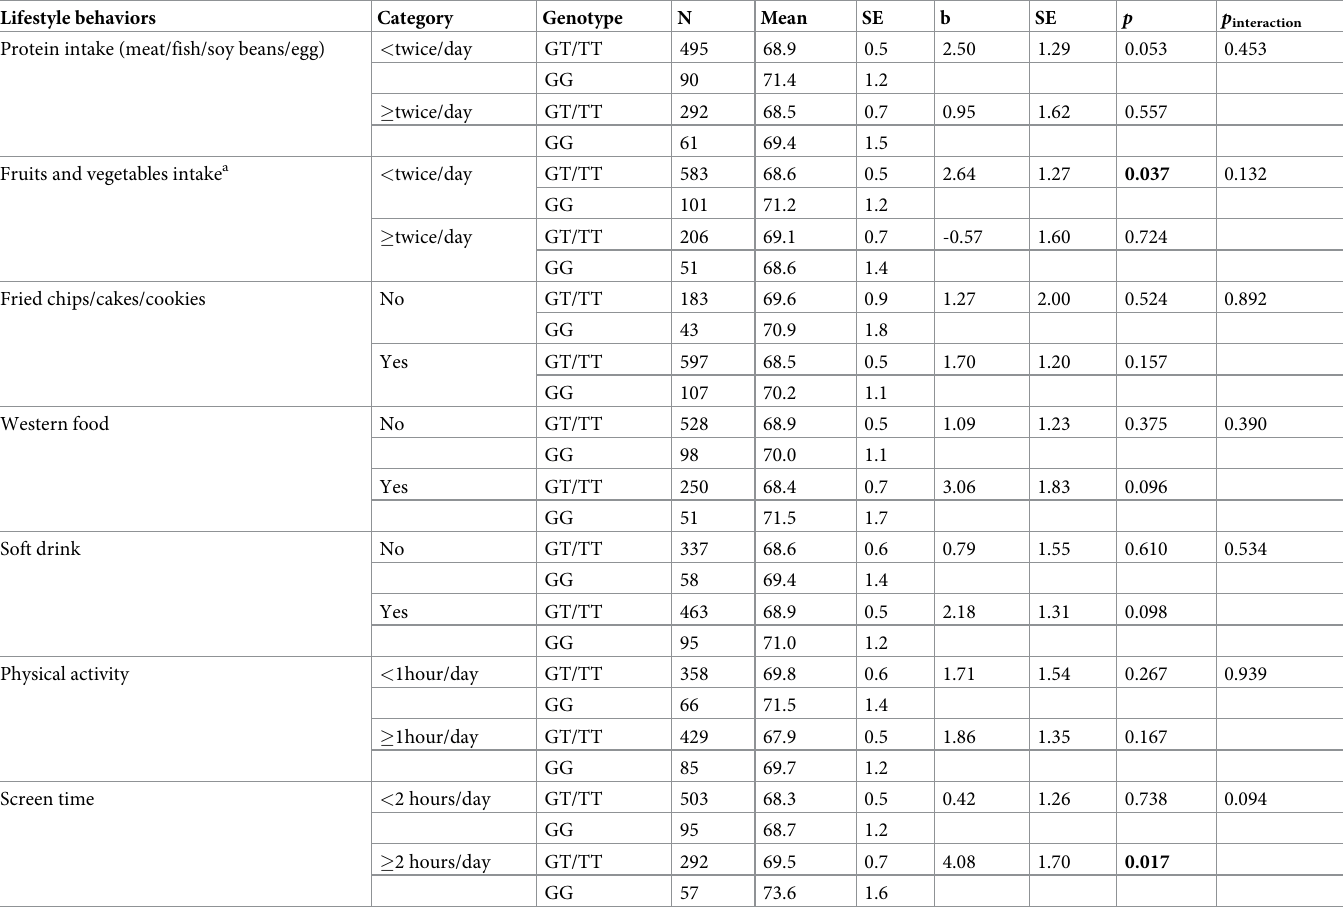
Table 4. Interaction between lifestyle behaviors and the CACNA1D rs9810888 polymorphism on MAP. Lifestyle behaviors Protein intake (meat/fish/soy beans/egg)